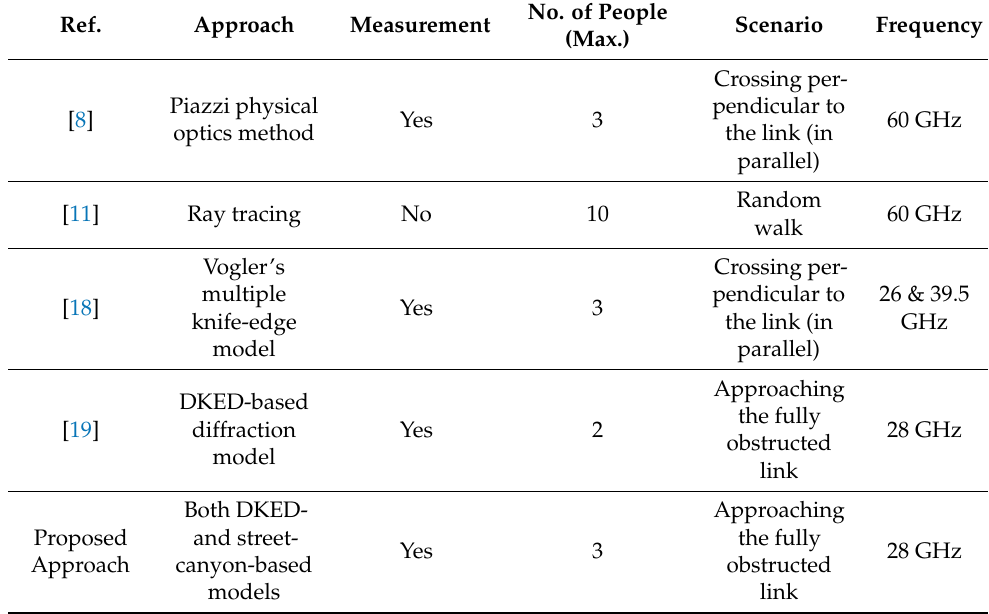
Table 1. Comparison between the related works and the proposed approach.